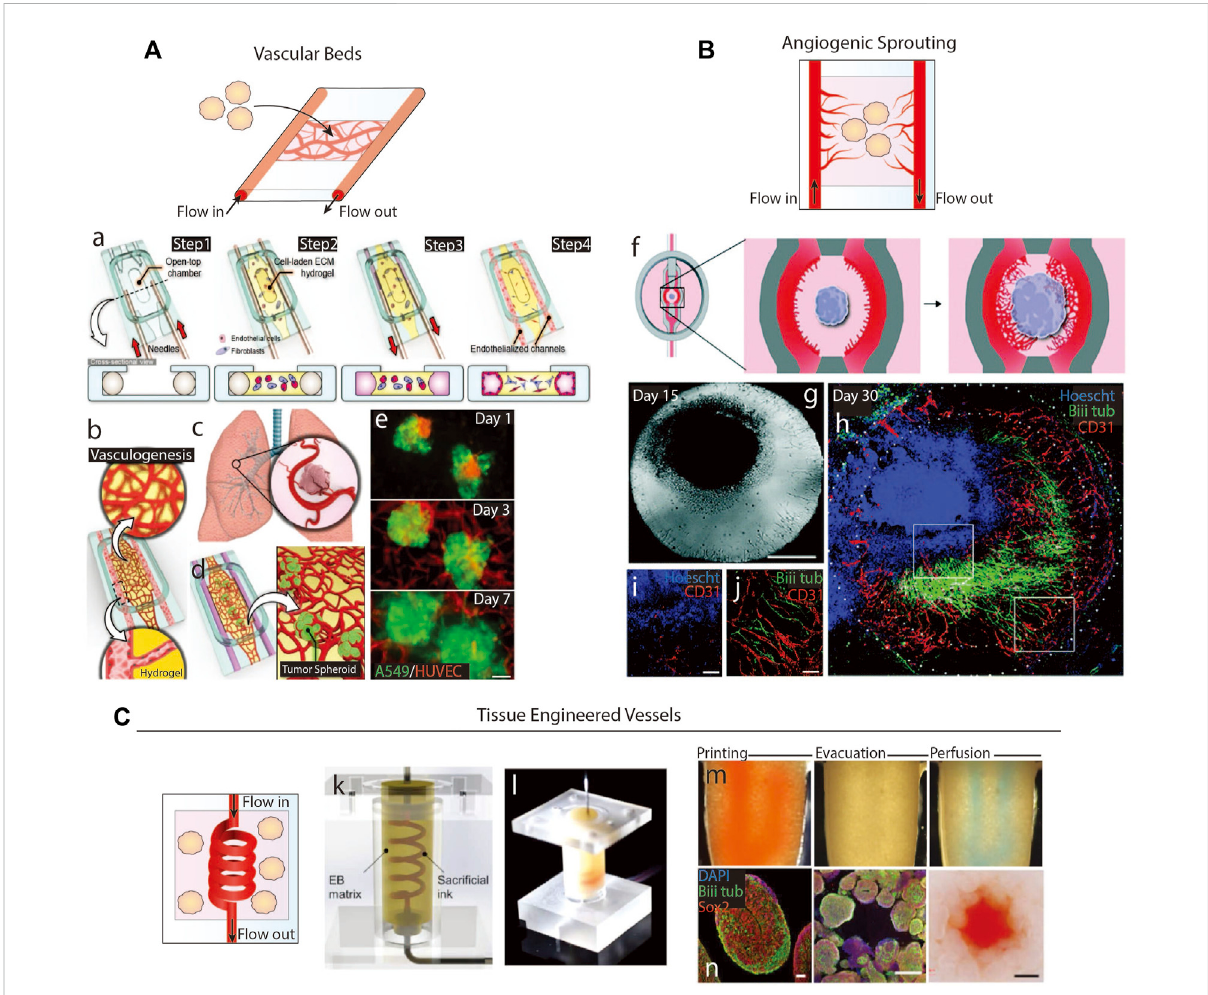
FIGURE 4 Micro fl uidics-based methods of vascularization. (A) Schematic of organoid vascularization using a micro fl uidic-generated vascular bed. a.b. Schematicshowingthefabricationofavascularbed.c.d.e.Introductionoflungtumorspheroidstothevascularbed.Adaptedfrom(Paeketal.,2019). (B) Schematic of organoid vascularization by angiogenic sprouting towards a central brain organoid. g. Image of the organoid and angiogenic sprouts. h.i.j. Organoid and angiogenic sprouts fl uorescently stained to show interaction between vessels and neurites. Adapted from (Salmon etal.,2022). (C) Schematicoftissueengineeredvesselthroughamatrixcontainingorganoids.k.l.Amicro fl uidicdeviceformedfromasacri fi cialinkin anembryoidbodymatrix.Whenasacri fi cialinkisevacuated,thesystemisthenperfusable.n.Imagesofbrainorganoidsinthedeviceafterperfusion. Adapted from (Skylar-Scott et al.,